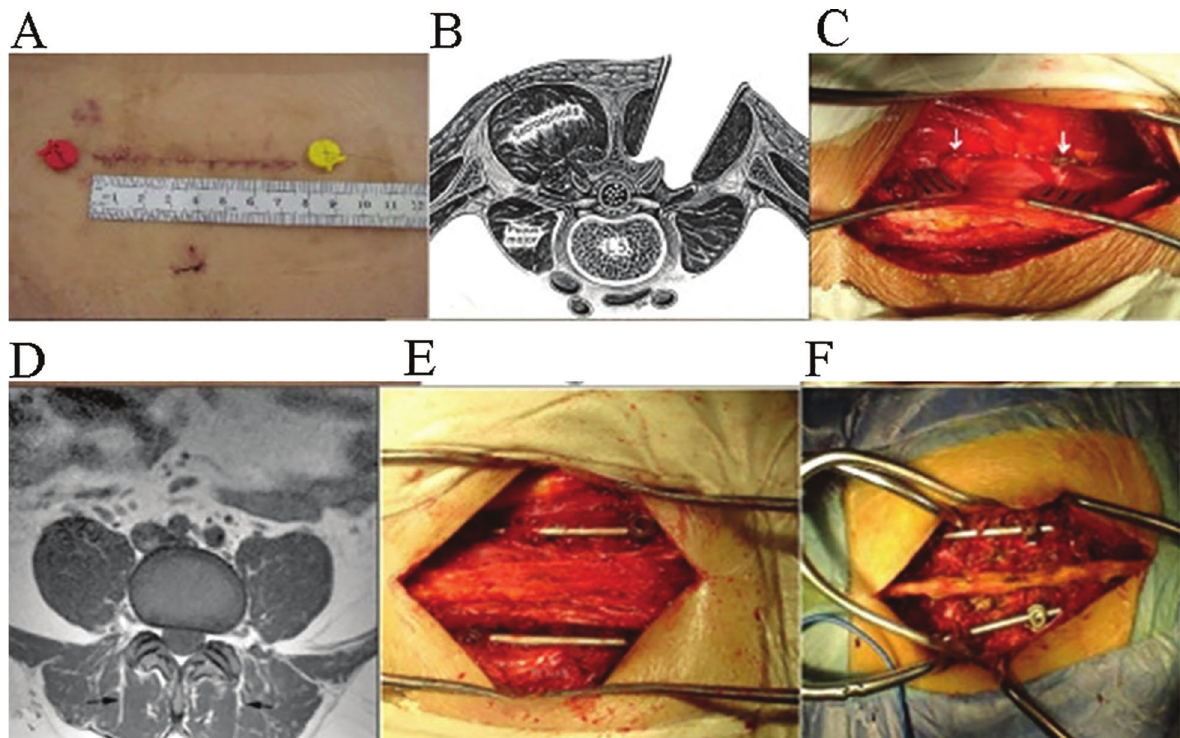
Figure 2. Surgical diagram. A , incision was minimized to 7 – 8 cm long. B , initial description by Wiltse of the paraspinal sacrospinalis- splitting approach to the lumbar spine showing the plane between the longissimus part and the multi fi dus part of the sacrospinalis muscle. C , facet joints are well exposed in the natural cleavage between the multi fi dus and the longissimus, which are the entering points of the pedicle screws. D , MRI shows the natural cleavage between the multi fi dus muscles. Paraspinal muscles are left intact in the paraspinal approach ( E ) compared with the traditional posterior approach ( F ). After surgery using pedicle and rod system internal fi xation by the paraspinal approach, the composite of posterior column was preserved integrally ( E